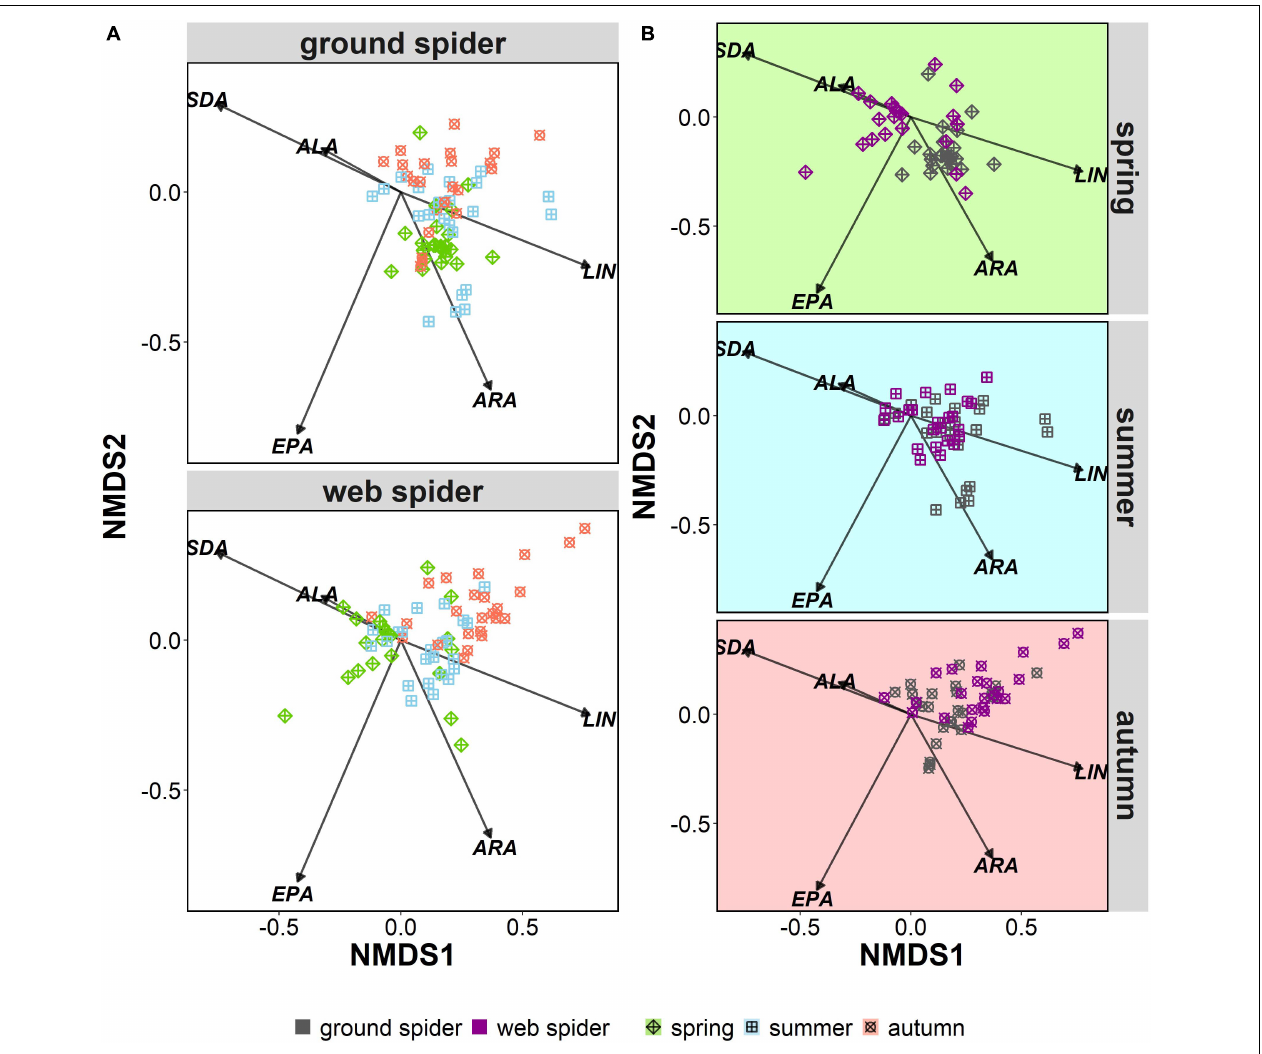
FIGURE 4 | Non-metric multidimensional scaling (nMDS) of arcsine-square-root-transformed PUFA (% of total fatty acids) of riparian spiders. Stress level = 0.15. LIN , linolenic acid; ALA , alpha-linolenic acid; SDA , stearidonic acid; ARA , arachidonic acid; EPA , eicosapentaenoic acid. Organized by (A) seasonal differences in ground spiders and web spiders, and (B) differences between spider types per